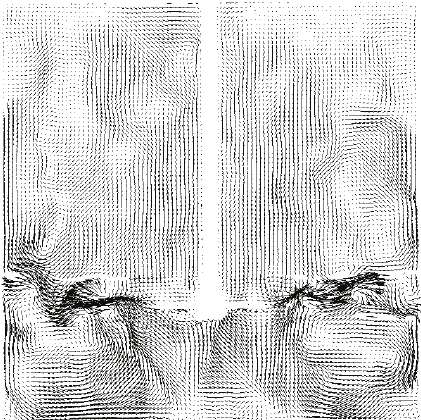
Figure 3: Calculated instantaneous flow field in measured plane between the baffles.